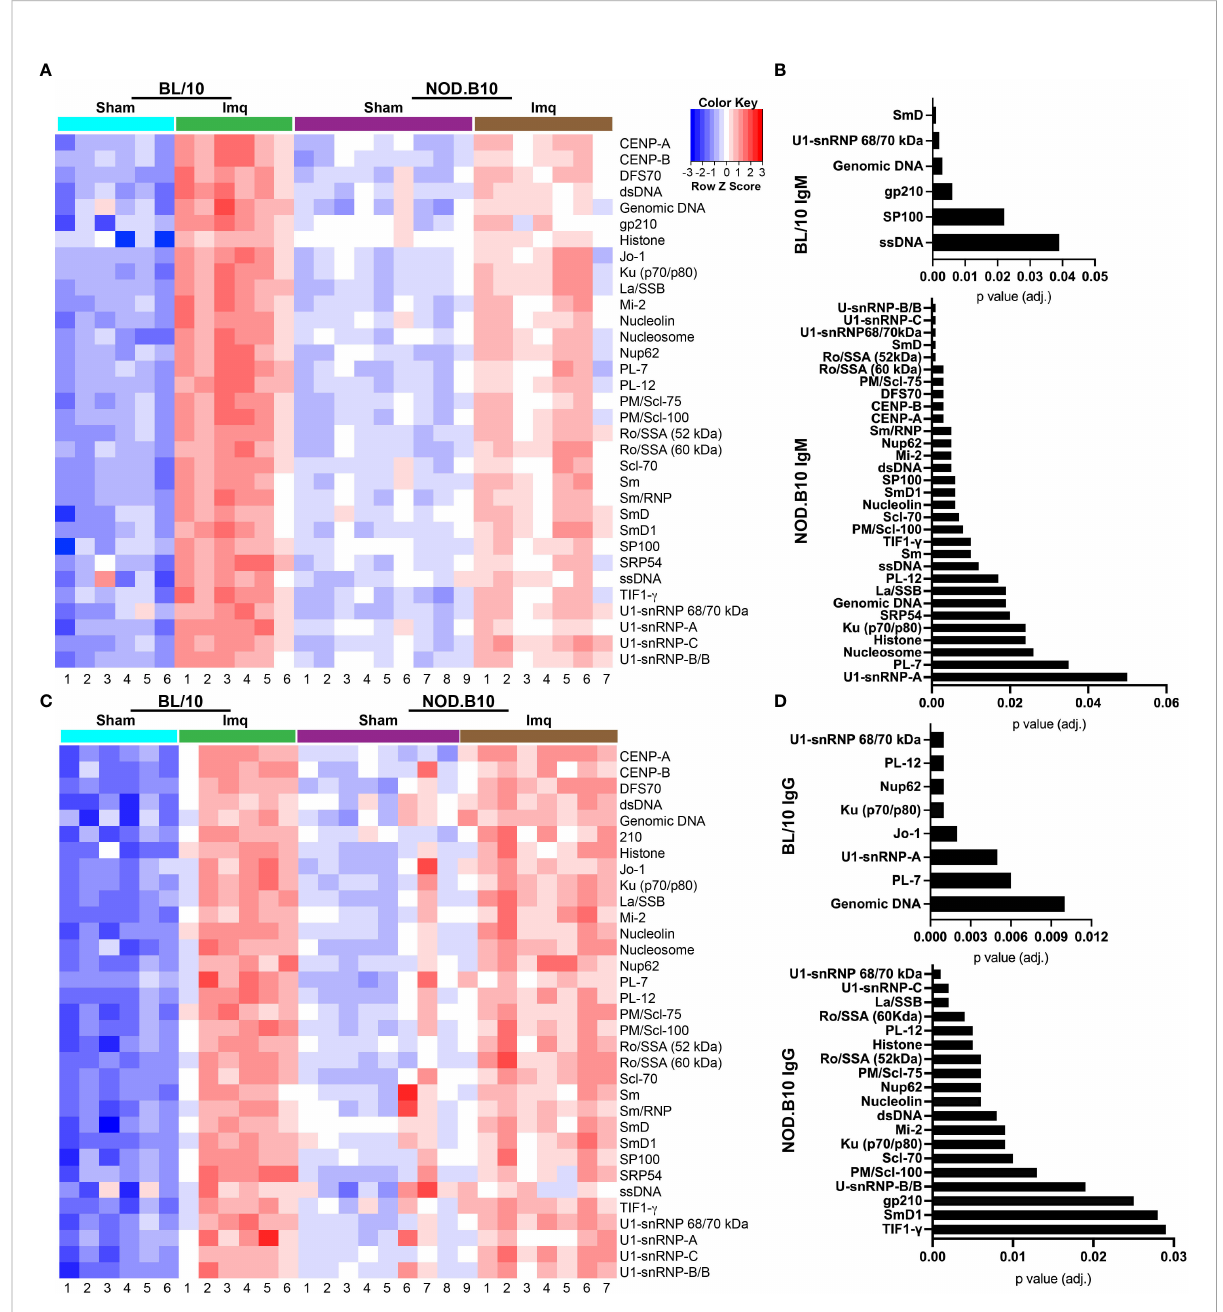
FIGURE 5 Autoantigen arrays reveal enrichment of autoantibodies in the sera of Imq-treated NOD.B10 mice. Sera were harvested from NOD.B10 sham (n = 9) or Imq-treated female mice (n = 7) by cardiac puncture following euthanasia. Sera were harvested similarly from BL/10 sham (n = 6) or Imq-treated female BL/10 mice (n = 6). Autoantigen arrays were performed and heatmaps for ANA-speci fi c (A) IgM and (C) IgG are shown. ANA-speci fi c (B) IgM and (D) IgG that was signi fi cantly enriched in Imq-treated BL/10 and NOD.B10 mice as compared to sham-treated strain- matched controls is